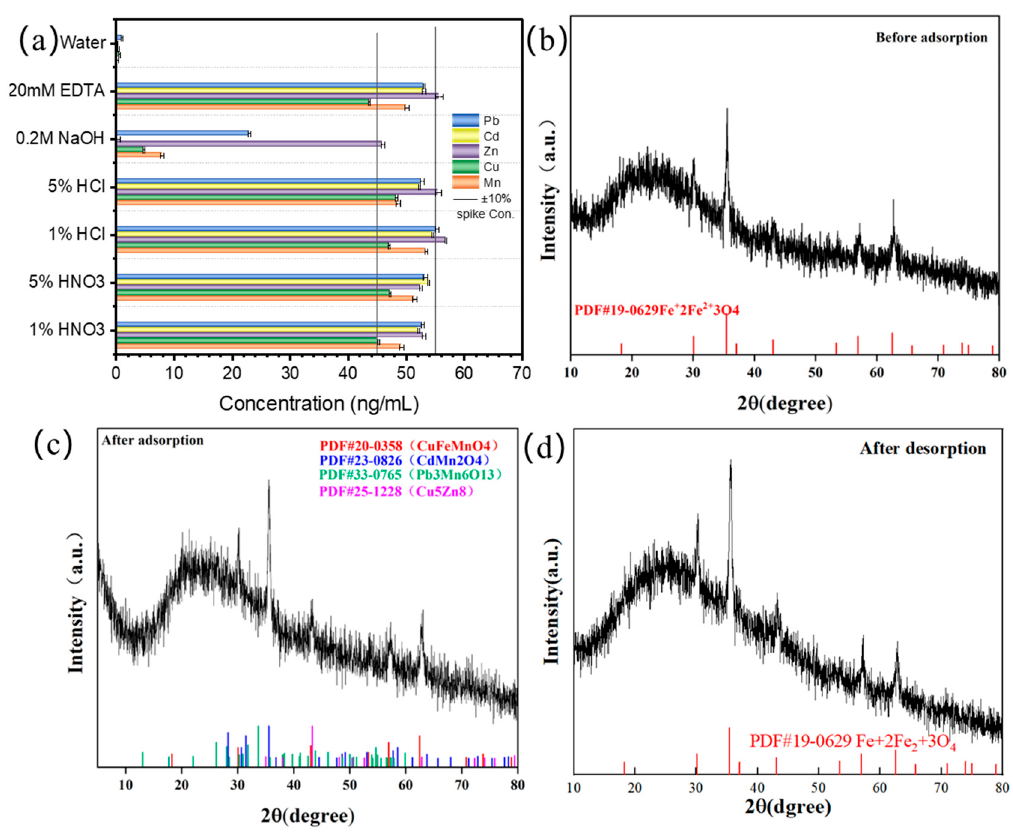
Figure 4. ( a ) Effect of the eluent condition for Mn, Cu, Zn, Cd, and Pb; ( b ) XRD pattern before adsorption; ( c ) XRD pattern after adsorption; ( d ) XRD pattern after desorption.